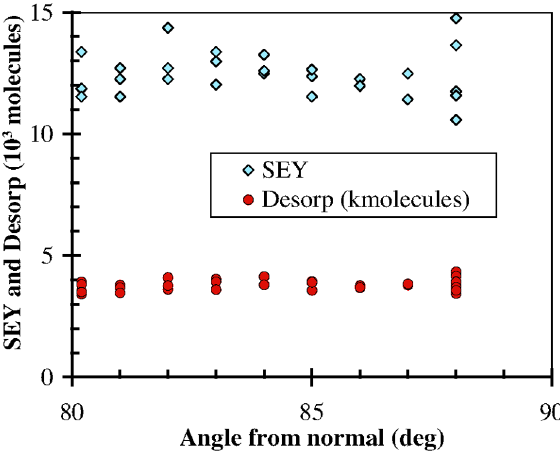
FIG. 15. (Color) The electron emission coefficient (SEY, blue diamonds) averages 12 : 5 (cid:14) 0 : 9 (standard deviation) and the gas desorption coefficient (red circles) averages 3 : 8 (cid:2)(cid:14) 0 : 2 (cid:3) (cid:9) 10 3 molecules for 1 MeV K (cid:6) incident on stainless steel roughened by bead